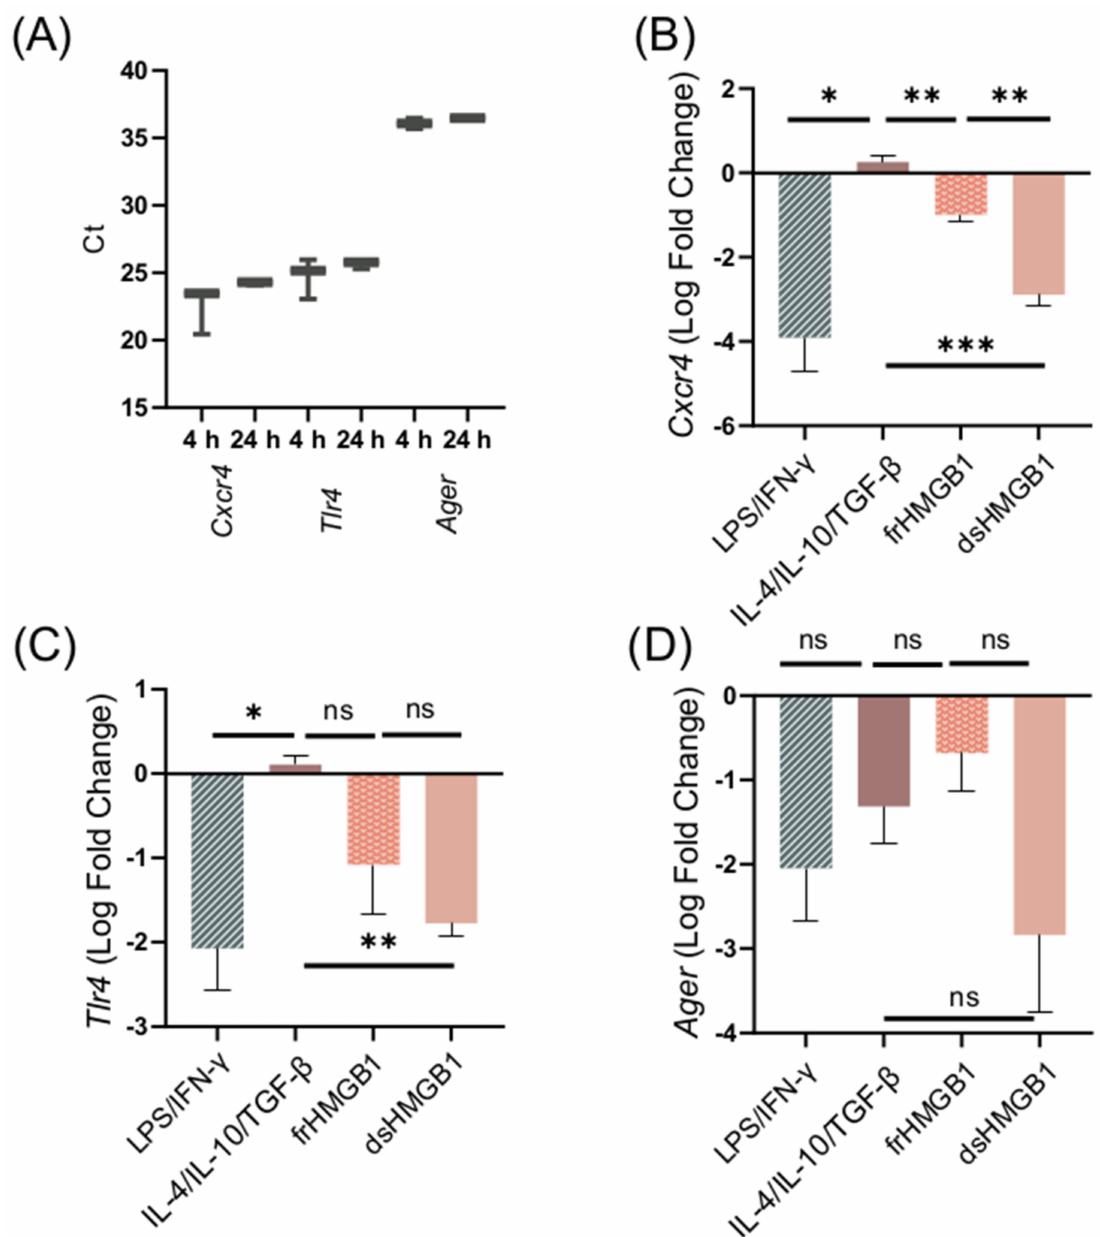
Figure 6. The expression of Cxcr4 , Tlr4 , and Ager in BMDMs is downregulated after dsHMGB1 and frHMGB1 stimulation. ( A ) Cxcr4 , Tlr4 , and Ager expression in unstimulated BMDMs. Data represent Ct values n = 3 (interquartile range). The gene expression of ( B ) Cxcr4 , ( C ) Tlr4 , and ( D ) Ager was determined from BMDMs incubated with LPS/IFN- γ , IL-4/IL- 10/TGF- β , 5 µ g/mL frHMGB1, or 5 µ g/mL dsHMGB1 for 24 h. Data represent n = 3 (mean ± SD). Statistical comparisons were performed using an ANOVA and a Dunnett’s multiple comparisons test. ns: not significant; * p ≤ 0.05, ** p ≤ 0.01, *** p ≤